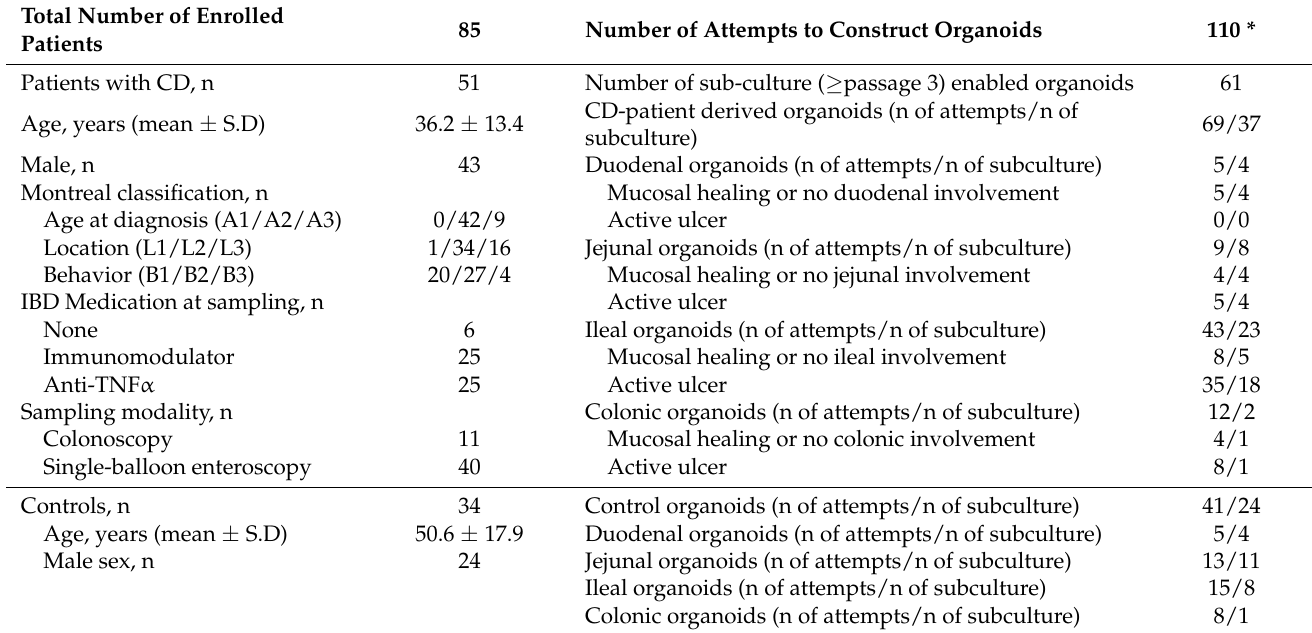
Table 1. Characteristics of the enrolled patients, and the number of attempts at constructing